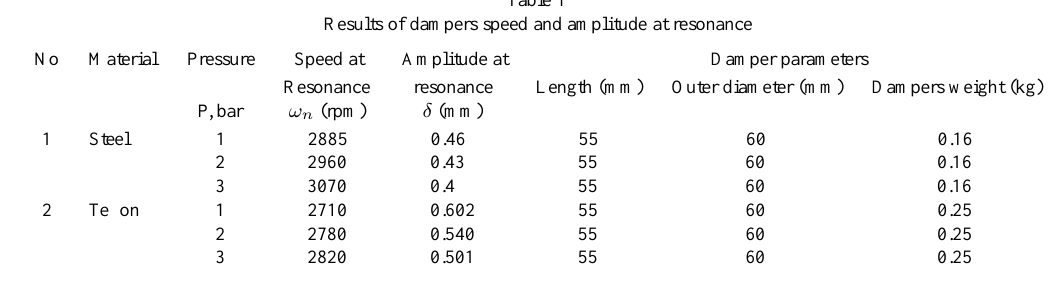
Table 1 Results of dampers speed and amplitude at